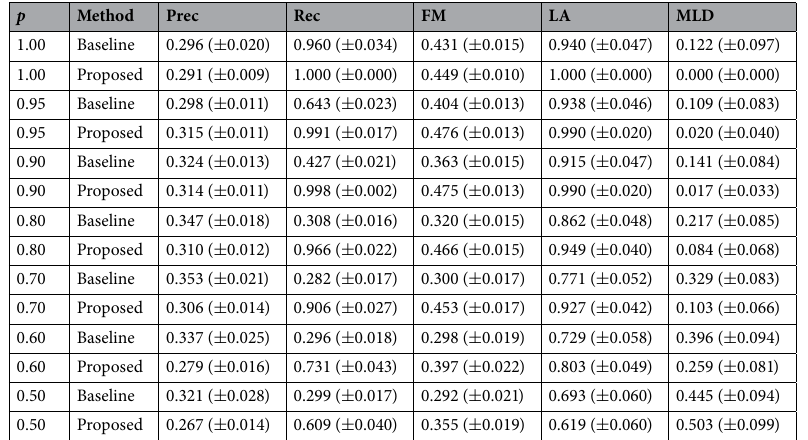
Table 2. Estimation performance of the baseline method and our proposed method using gap-based cost averaged over 100 datasets for 7 values of parameter p :0.50, 0.60, 0.70, 0.80, 0.90, 0.95, 1.00. We used Gaussian kernel with a bandwidth with the best β